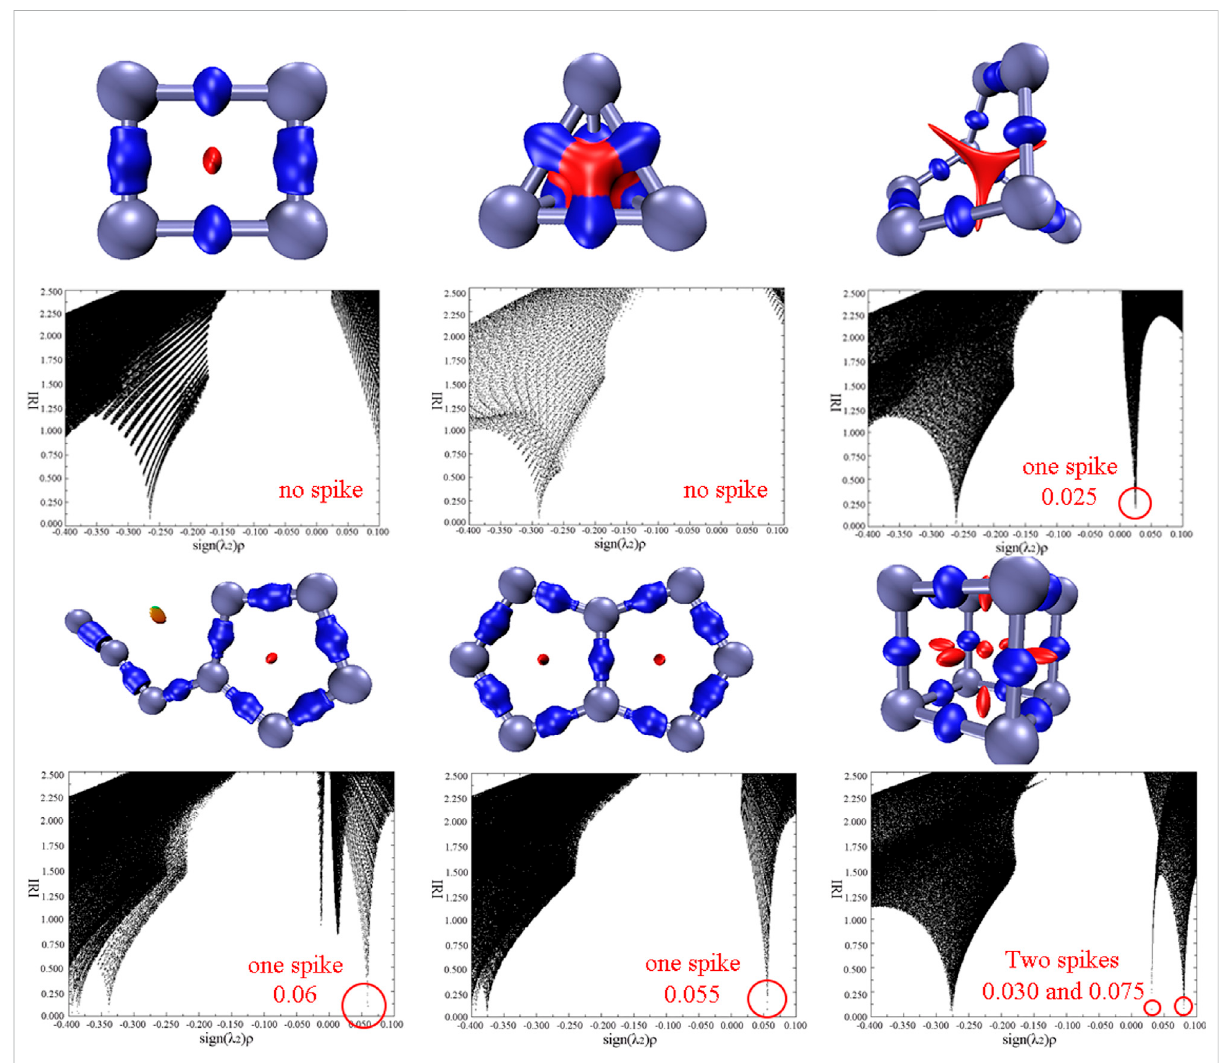
FIGURE 5 Isosurface maps of IRI= 1.0, and scatter map between IRI and sign( λ 2 ) ρ for N 4 -1, N 4 -2 , N 8 -1, N 8 -2, N 8 -3, and N 8 -4 , respectively. λ 2 represents the second largest eigenvalue of Hessian of the electron density, and ρ is the electron